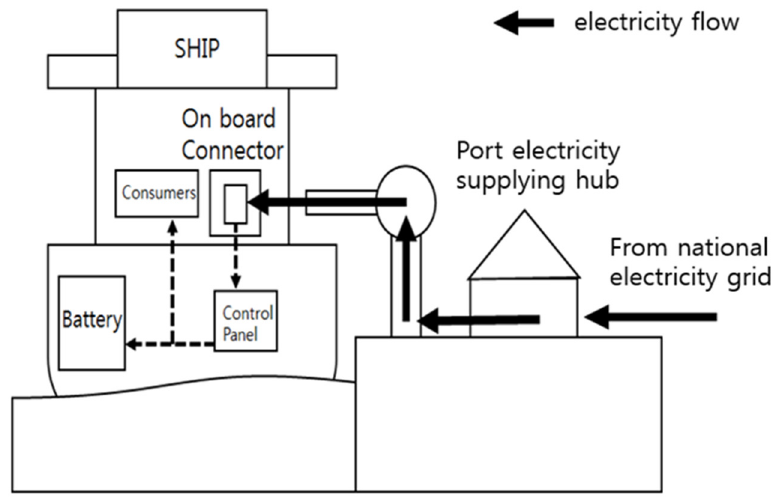
Figure 10. Concept of onshore power supply system.